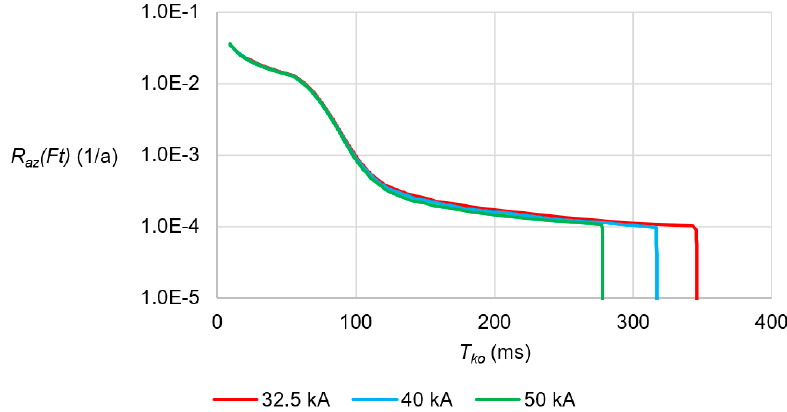
Figure 16. Risk of exceeding force F t versus T ko for three short circuit current values (point A).